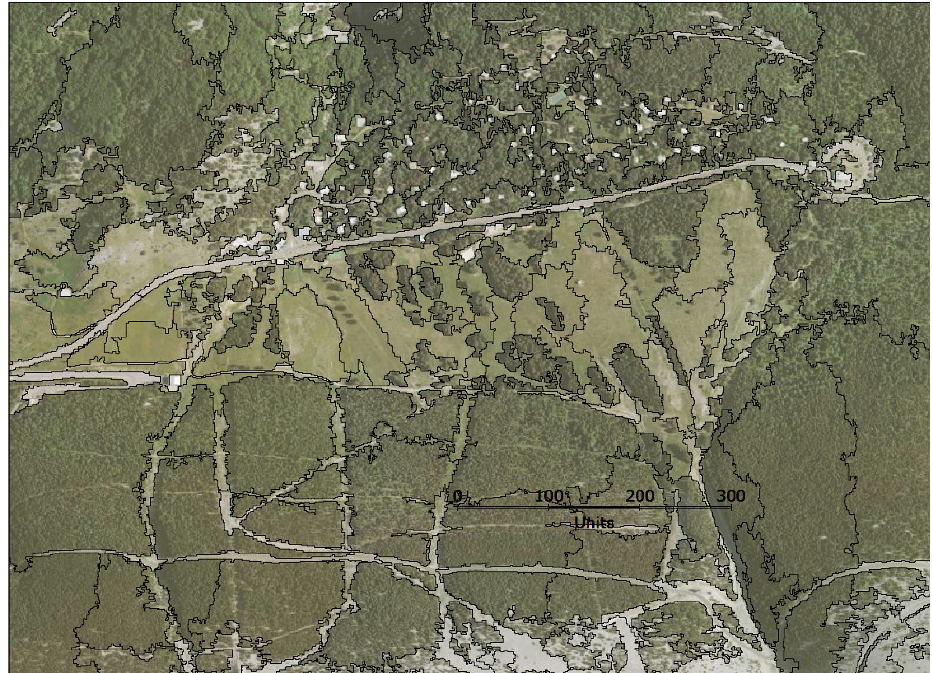
Figure 4. Segmentation obtained using Baatz and Schäpe algorithm with scale 70